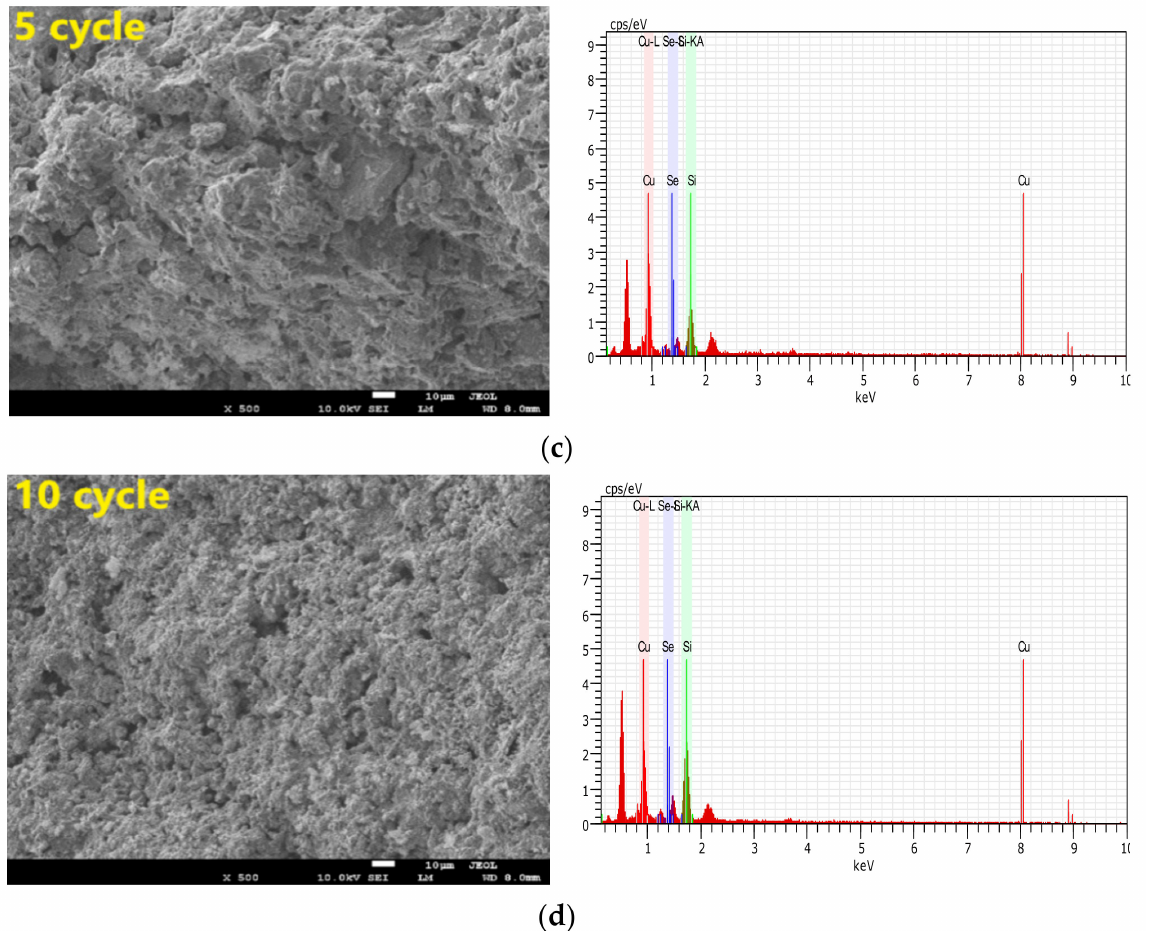
Figure 11. SEM and EDS images of SX bitumite samples with CuO/Ben oxygen carrier: ( a ) Fresh samples; ( b ) after two cycles; ( c ) five cycles and ( d ) 10